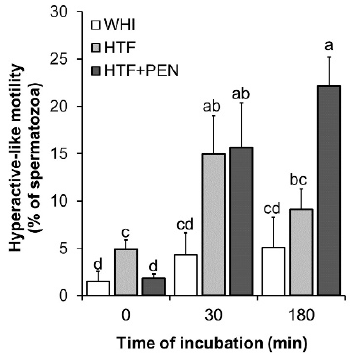
Figure 2. Percentage of spermatozoa showing hyperactive-like motility. Kinetics were examined at the time points 0, 30, and 180 min of incubation in Whitten’s medium (WHI), synthetic human tubal fluid (HTF), or HTF supplemented with 750 µM of penicillamine (HTF + PEN). Spermatozoa showing hyperactive-like motility were defined as those showing VCL > 150 and ALH > 5.5. a, b, c, d Different letters indicate significant differences ( p < 0.05, n = 6, 12 determinations).